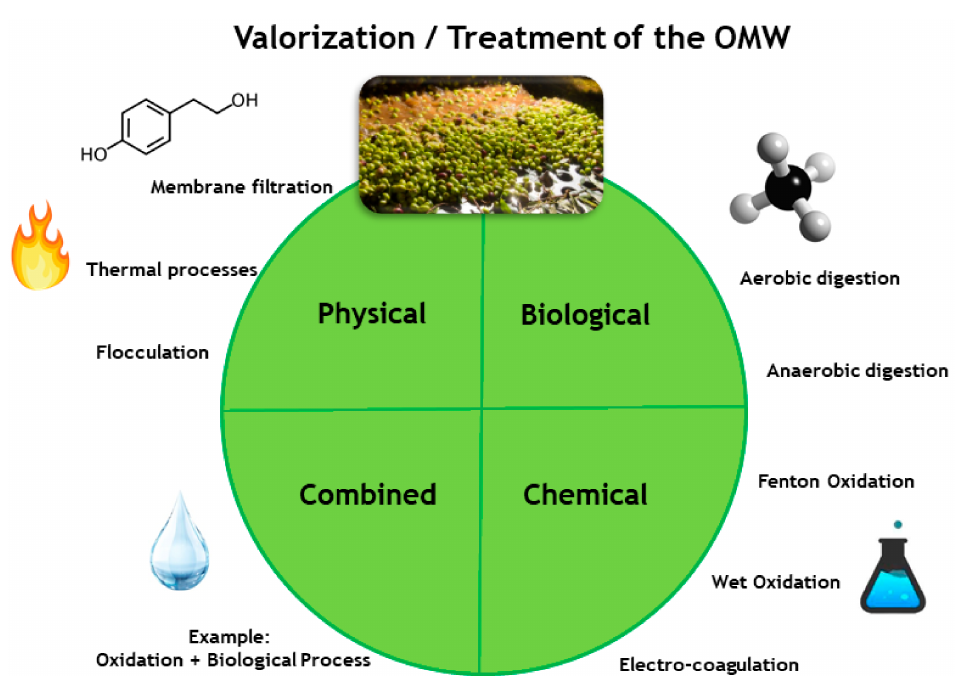
Figure 5. General scheme of different techniques applicable for OMW treatment/valorization